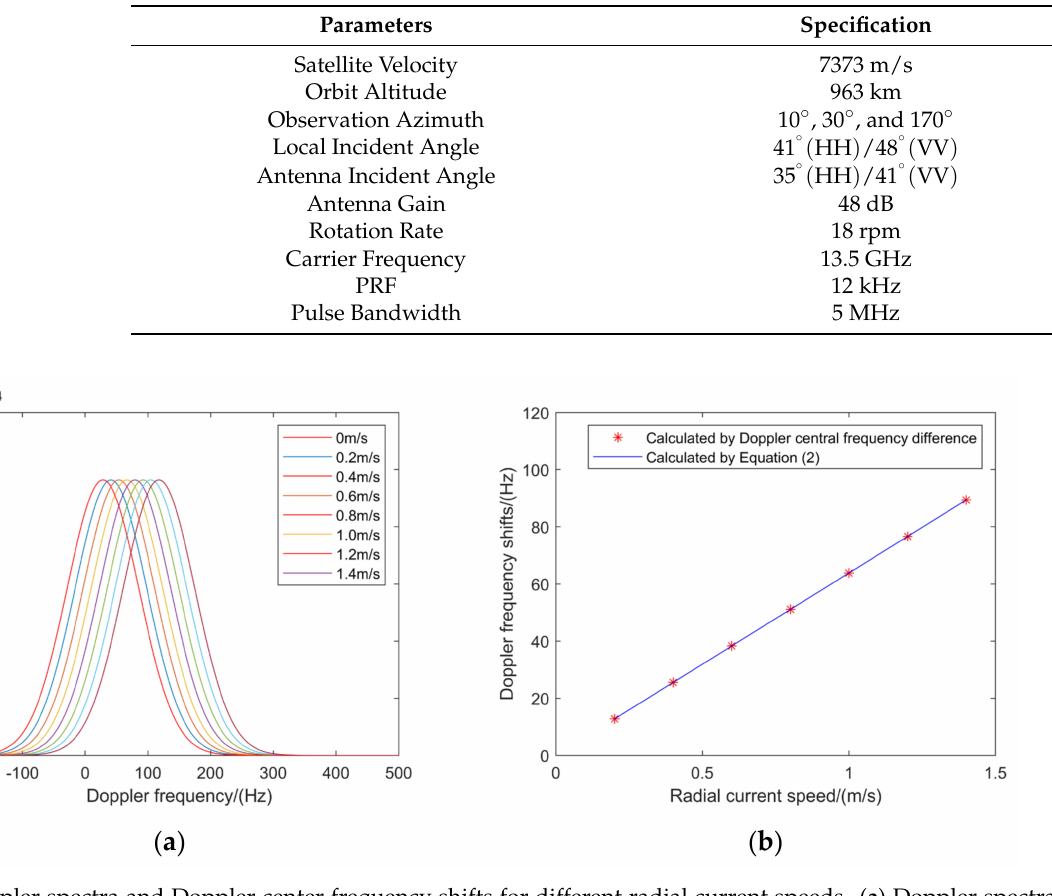
Figure 6. Doppler spectra and Doppler center frequency shifts for different radial current speeds. ( a ) Doppler spectra. ( b ) Doppler frequency